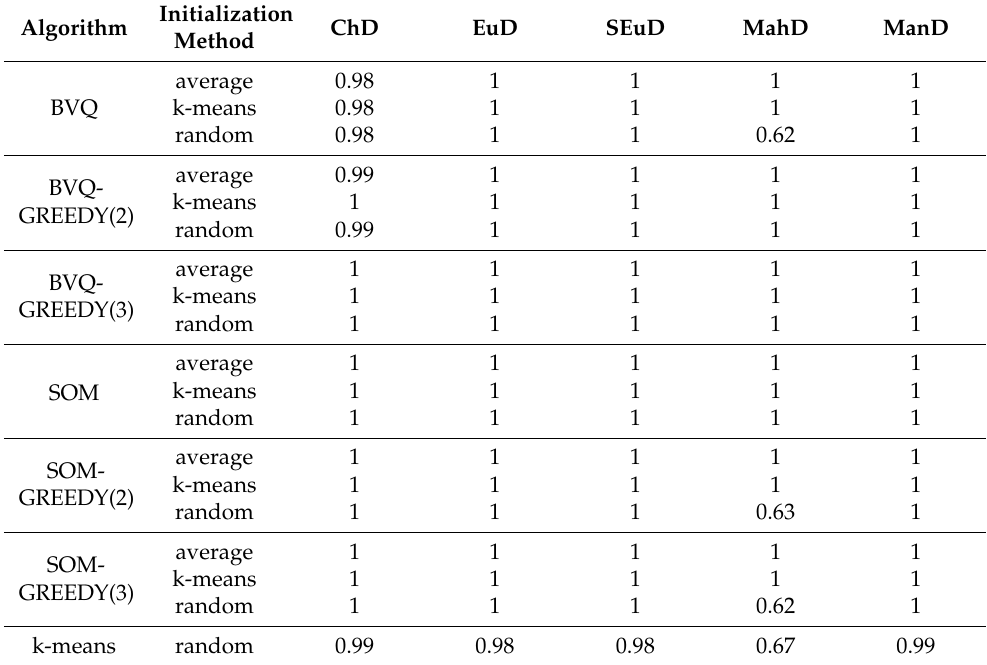
Table 6. Accuracy of device clustering for BVQ, SOM, BVQ-GREEDY(2), BVQ-GREEDY(3), SOM- GREEDY(2) and SOM-GREEDY(3) algorithms (two-batch mixed lot).